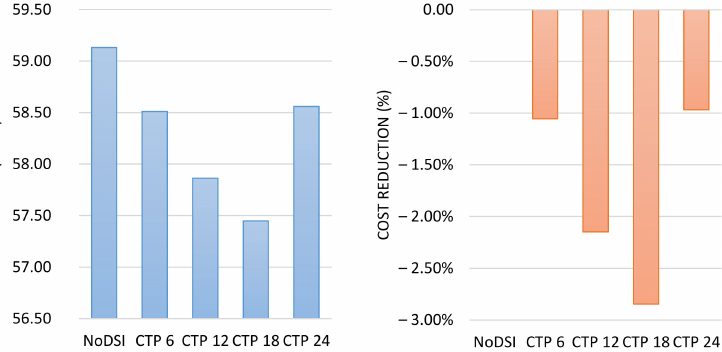
Figure 10. Total system costs ( left graph ) and relative cost reduction ( right graph ) by changing the preset compensation compared to the reference scenario without BEV-DSI .